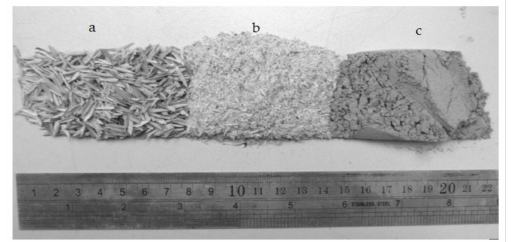
Figure 8. ( a ) RiH; ( b ) burned RHA; ( c ) grinded RHA [31].